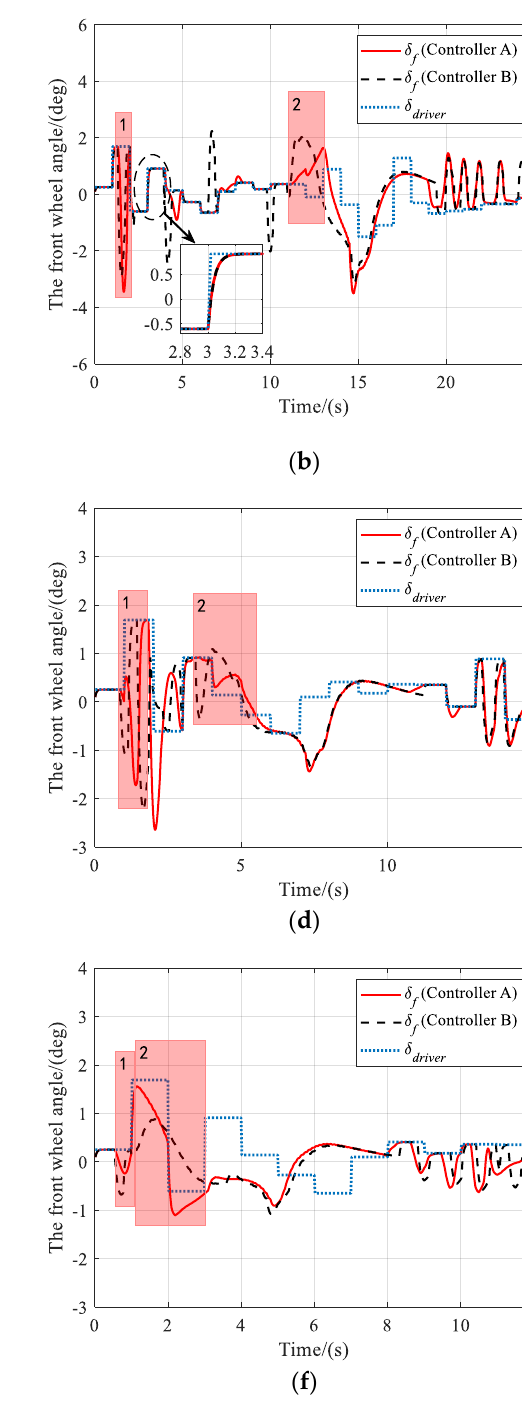
Figure 11. Scenario 3: Simulation results at different speed. ( a ) Vehicle trajectory at 36 km/h, ( b ) the front wheel angle at 36 km/h, ( c ) vehicle trajectory at 72 km/h, ( d ) the front wheel angle at 72 km/h, ( e ) vehicle trajectory at 108 km/h, and ( f ) the front wheel angle at 108